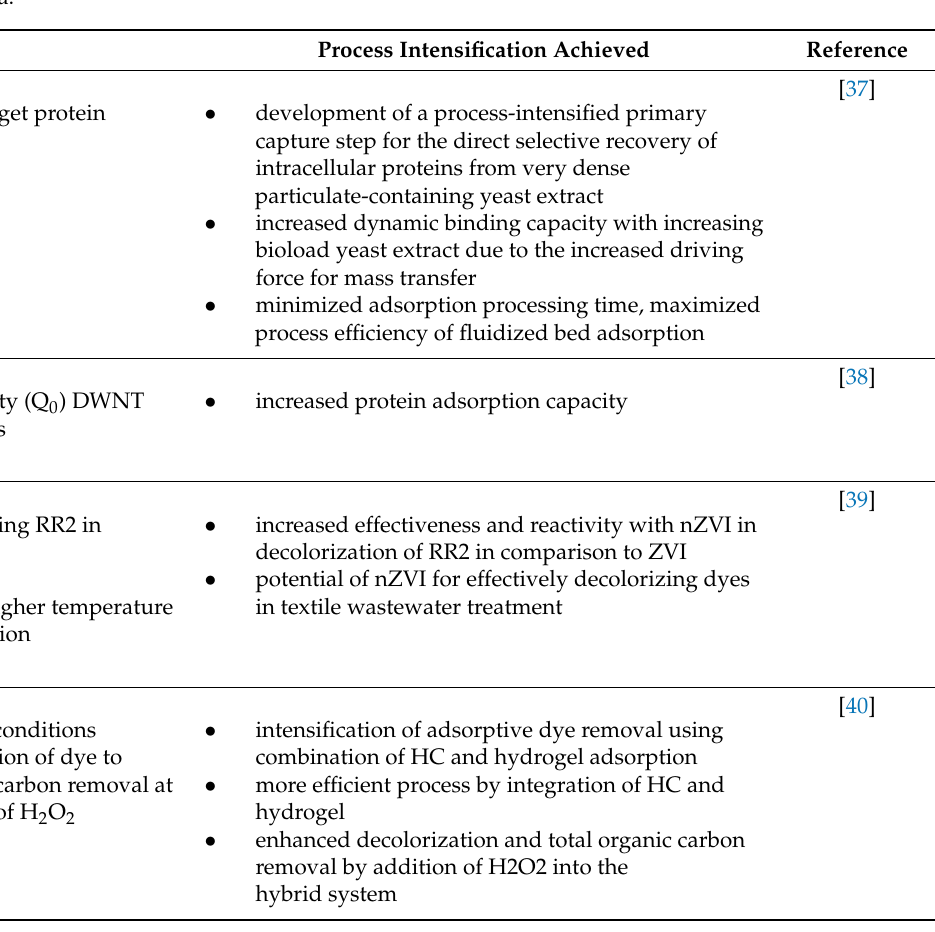
Table 2. Process intensification achieved in adsorptive separations: decolorization of dyes; removal of aromatic hydrocarbons from wastewaters; and recovery of proteins, heavy metals and rare earth elements from aqueous